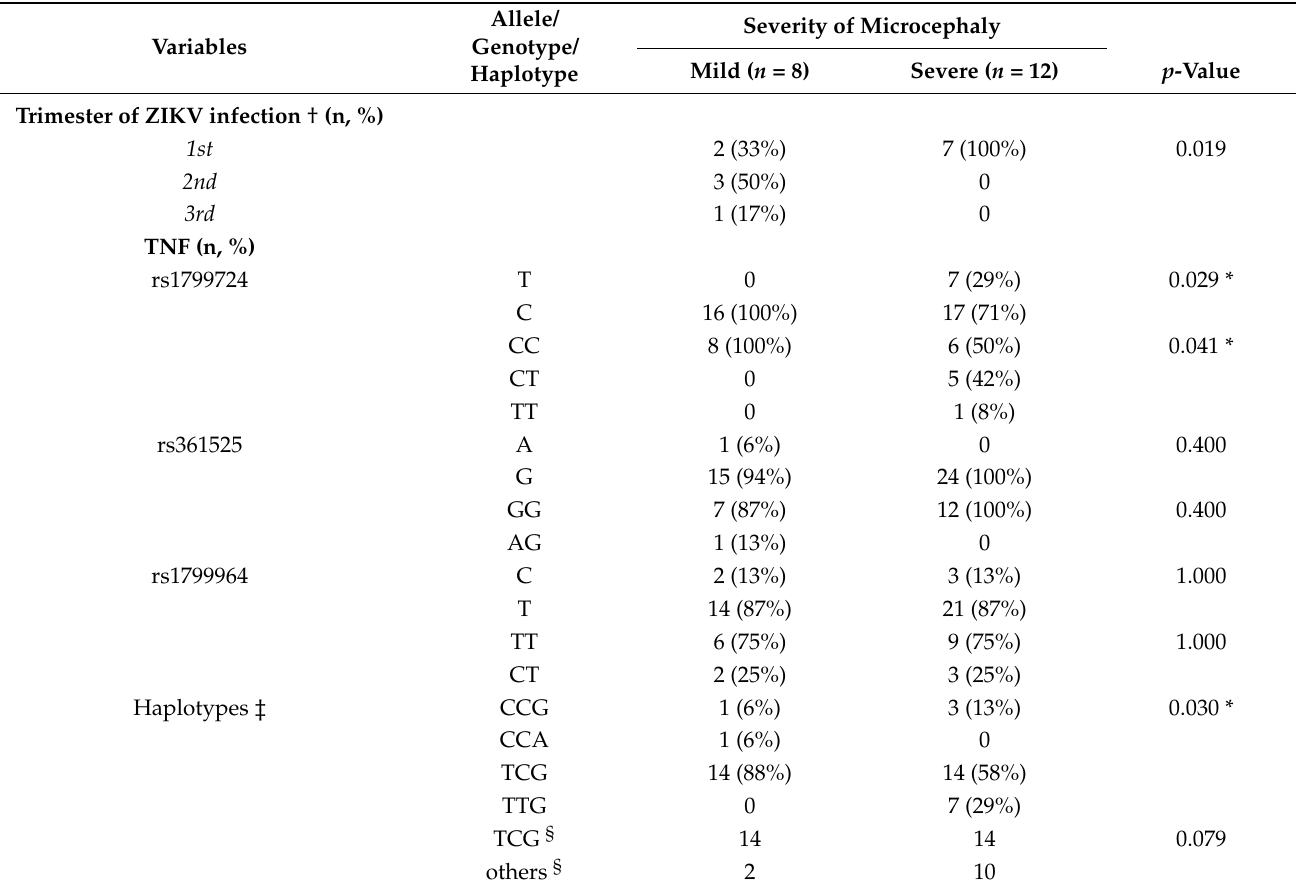
Table 5. Association between trimester of Zika virus (ZIKV) infection during pregnancy or TNF polymorphisms and the severity of microcephaly in cases with CZS. Allele/ Severity of Microcephaly Genotype/ Variables Mild ( n = 8) Severe ( n = 12) p -Value Haplotype Trimester of ZIKV infection † (n,